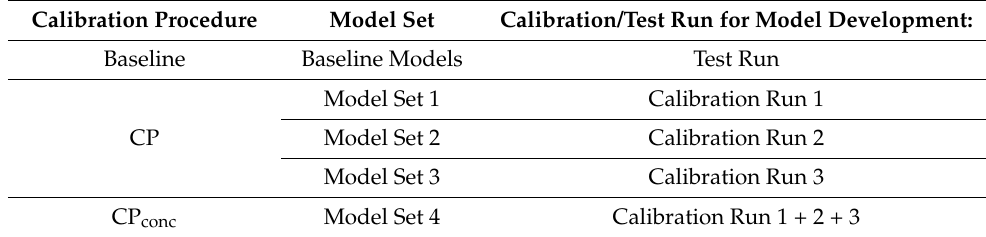
Table 2. Four sets of models for calibration procedure without and with the inclusion of concentration